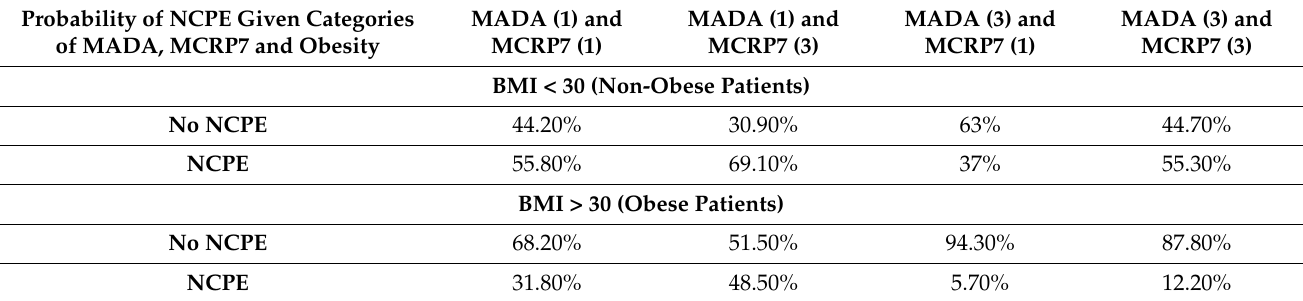
Table 13. The heat-mapped, conditional probabilities of NCPE given the different states of MADA, MCRP7 and Obesity. Probability of NCPE Given Categories of MADA, MCRP7 and Obesity